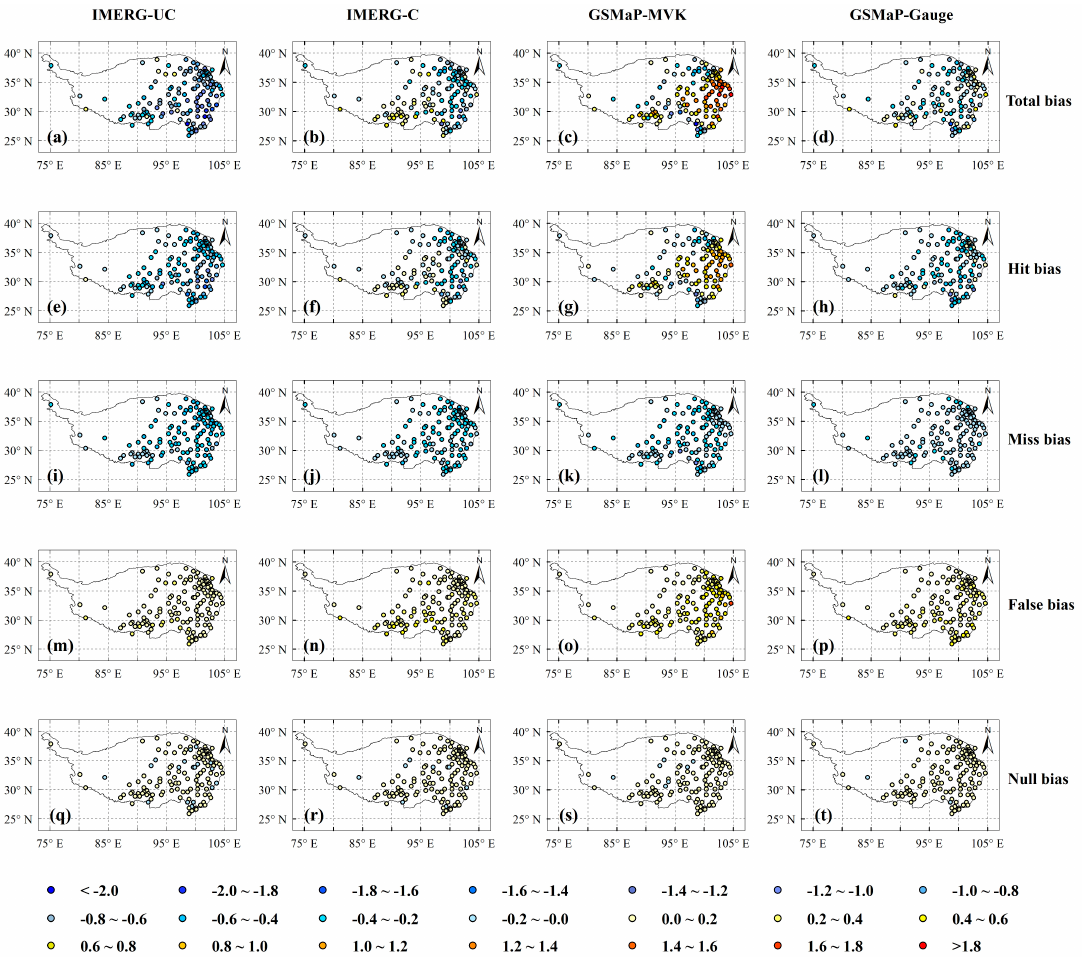
Figure 7. Spatial patterns of the error components of satellite precipitation estimates against CGDPA at the 132 grid central points (mm/day): total bias (first row), hit bias (second row), missed precipitation (third row), false precipitation (fourth row), and bias with selected threshold (fifth row).